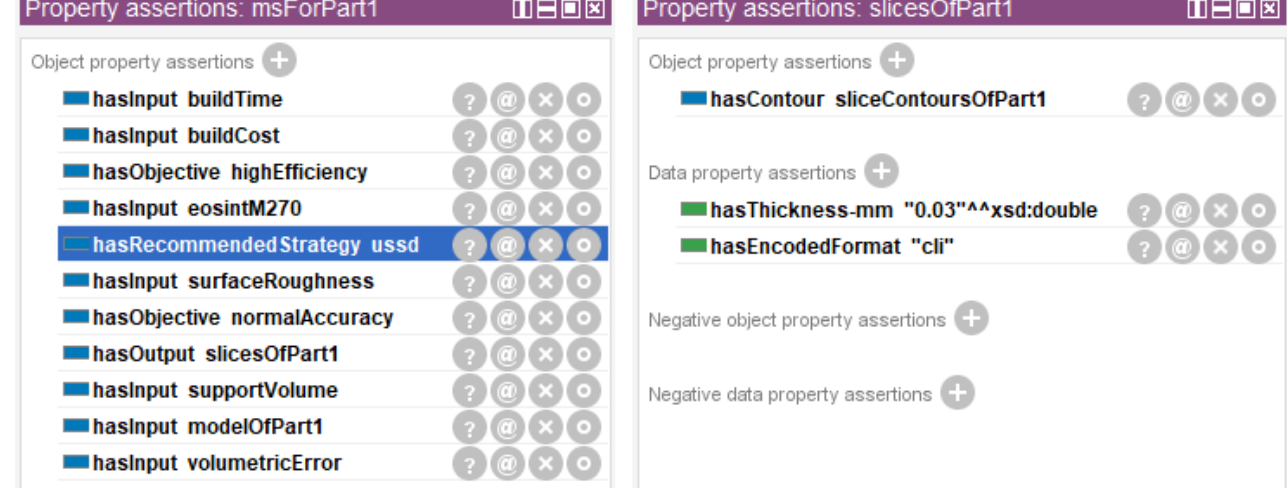
Figure 12. Results of model slicing for the LPBF part in the ontology.